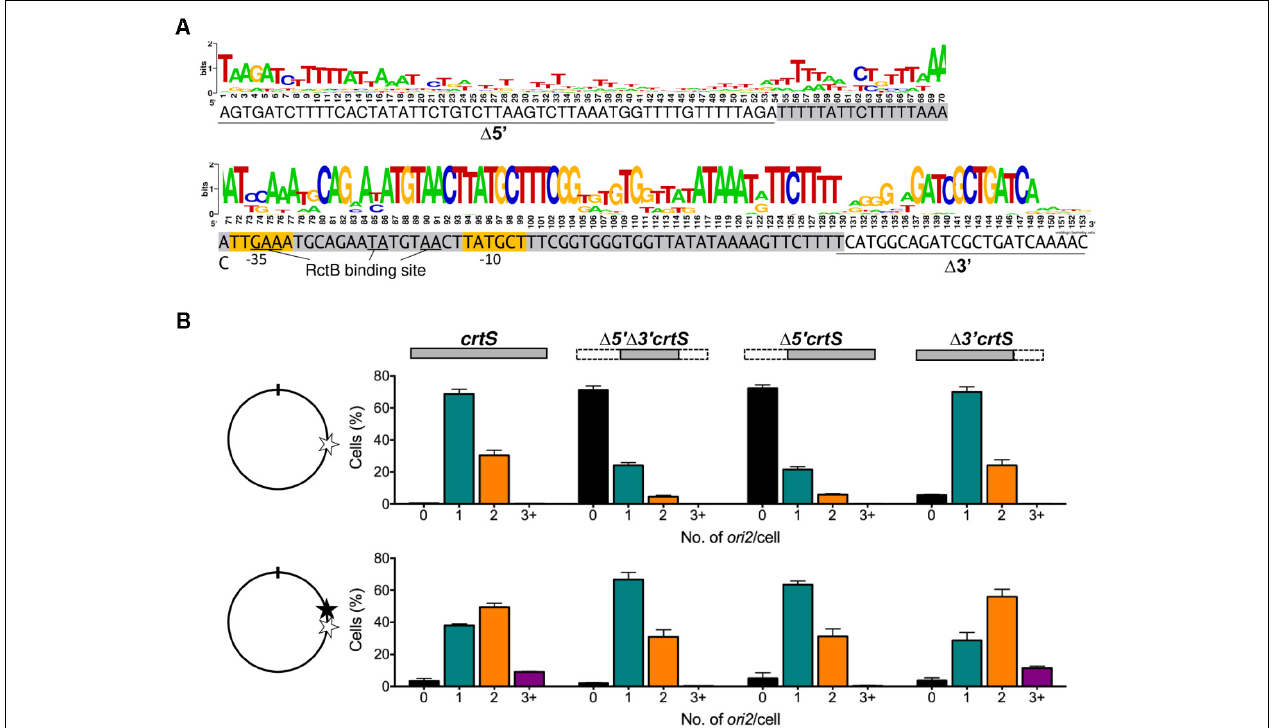
FIGURE 1 | The 5 (cid:48) but not the 3 (cid:48) end of crtS is critical for its function. (A) The 153 bp crtS sequence from V. cholerae overlaid with a WebLogo (Crooks et al., 2004), generated from different Vibrio species showing varied conservation along the length of the sequence, as in Kemter et al. (2018). Gray highlighted sequence denotes the minimal 70-bp that retain copy-number enhancement function of crtS in E. coli. The flanking 5 (cid:48) and 3 (cid:48) sequences studied here are underlined. Yellow highlighted sequences denote the predicted –35 and –10 elements of the sigma-70 promoter, P crtS . (B) The effect of crtS and its truncated derivatives on Chr2 replication is shown by histograms of ori2 foci numbers per cell in V. cholerae strains where crtS was replaced at its native locus with the truncated derivatives (top row), and where the same mutant strains had, at 10 kb upstream, a second full length crtS copy (bottom row). On the left of the histogram is shown the approximate location of crtS copies in Chr1, where the native locus is indicated by an empty star and the locus with the added crtS copy by a filled star. The position of the ori1 is denoted by a tick-mark. The strains used were: intact crtS (CVC3058, top; CVC3061, bottom), (cid:49) 5 (cid:48) (cid:49) 3 (cid:48) crtS (CVC3228, top; CVC3247, bottom), (cid:49) 5 (cid:48) crtS (CVC3227, top; CVC3246, bottom), (cid:49) 3 (cid:48) crtS (CVC3226, top; CVC3245, bottom). Note that deletion of the upstream 53 bases ( (cid:49) 5 (cid:48) ) severely compromises replication-triggering function of crtS as evidenced by the appearance of cells with zero ori2 foci. Data represent mean ± SEM (standard error of mean) of at least 1000 cells imaged from three biological